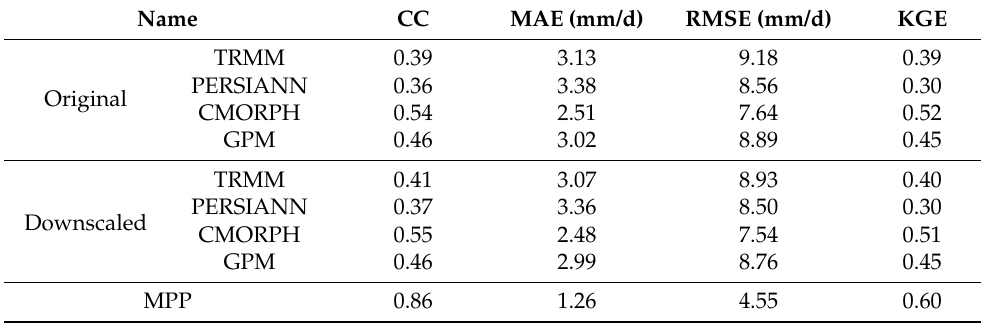
Table 3. CC, MAE, RMSE, KGE for the final MPP, the downscaled SPPs, and the original SPPs at a daily scale with a reference to gauge observations during 2007–2018.